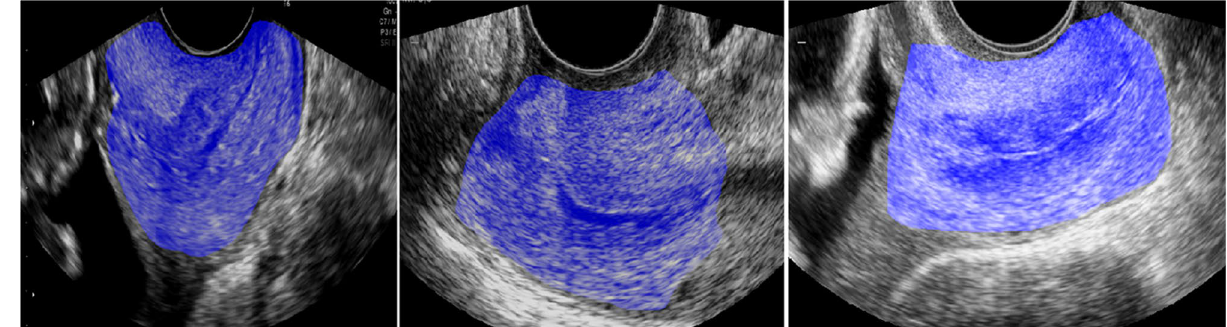
Figure 1. Example images and the automatic ROI delineation performed by